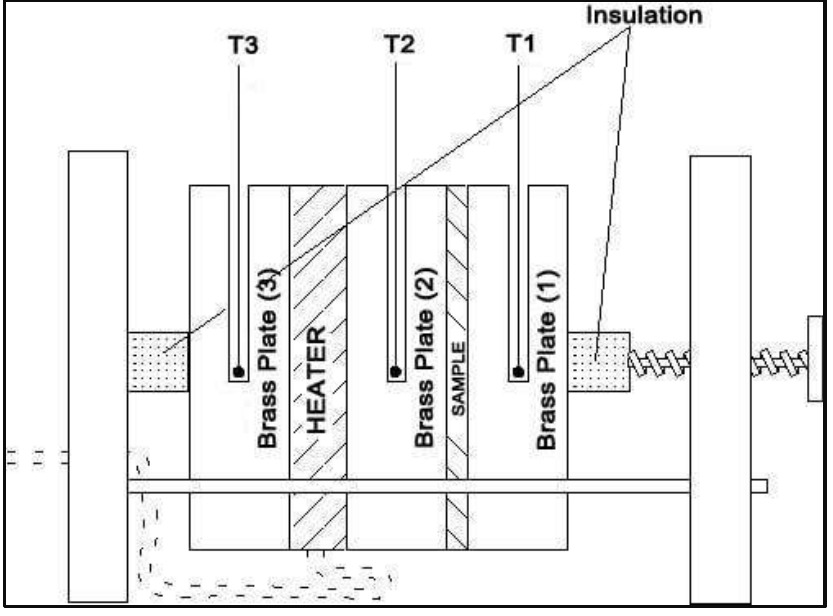
Figure 1: Scheme represents a lee's disk method for measuring thermal